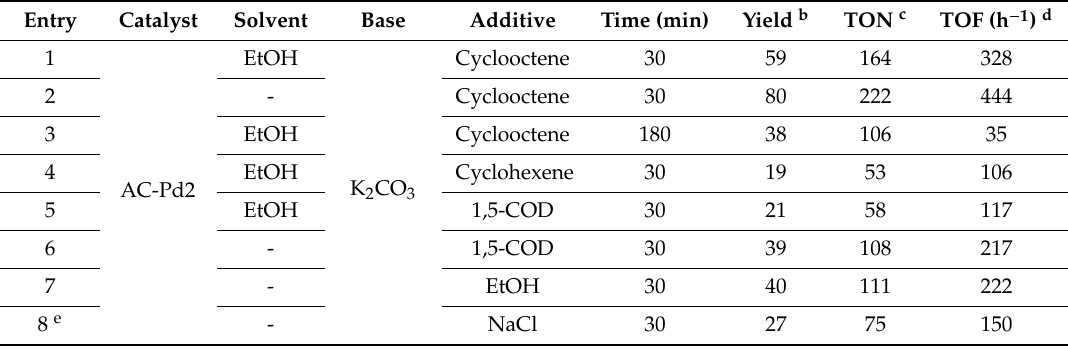
Table 5. E ff ect of di ff erent additives on the Suzuki-Miyaura cross-coupling reaction of bromobenzene with phenylboronic acid by AC-Pd2 a .